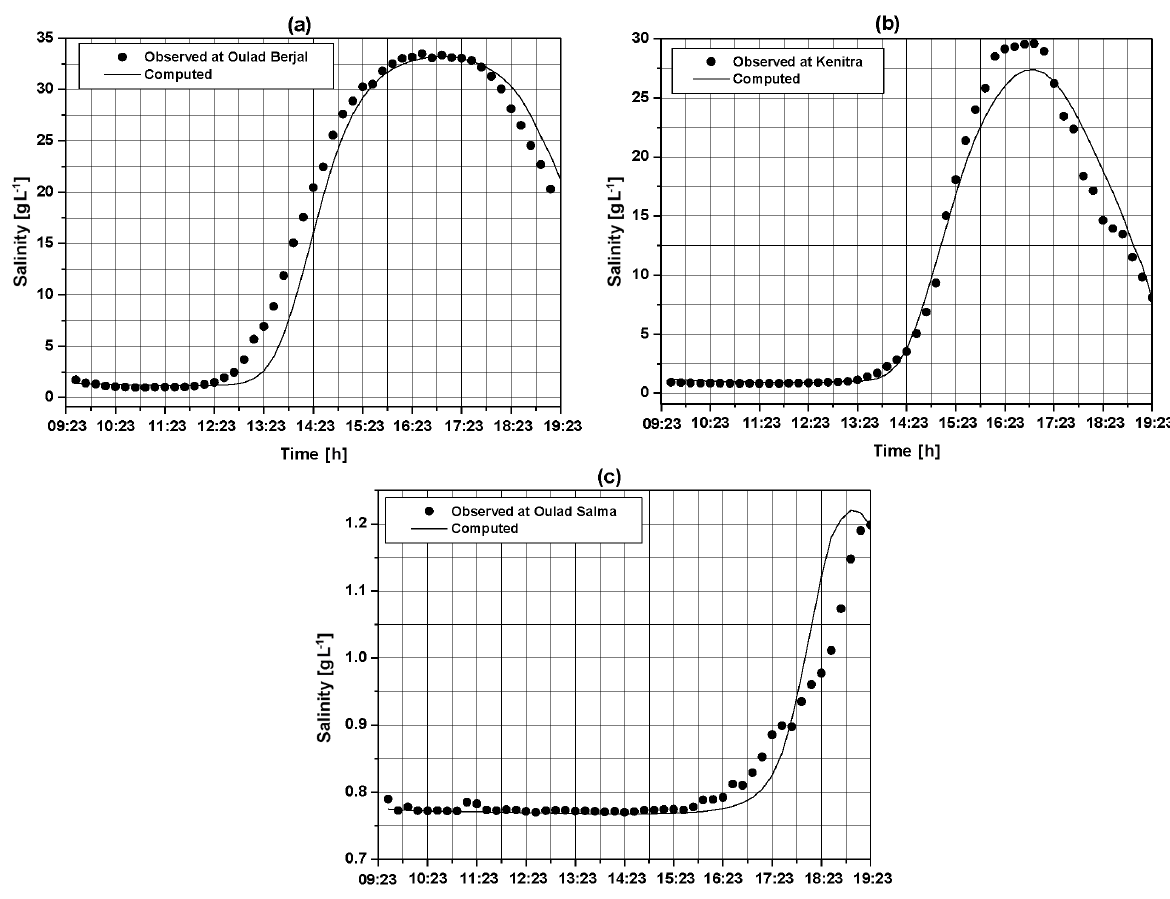
Figure 15. Salinity comparisons at Oulad Berjel (a) , Kenitra (b) and Oulad Salma (c) in calibration.